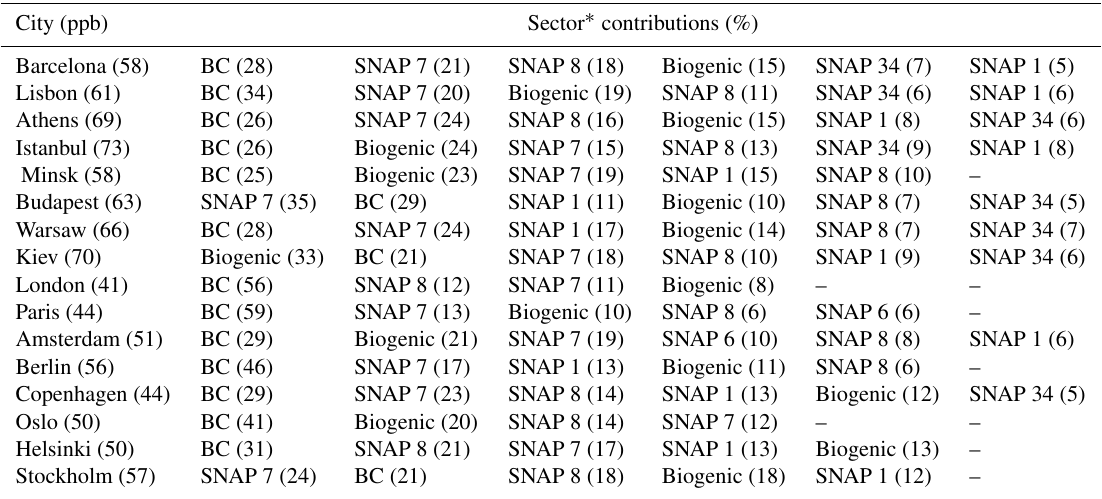
Table 6. Sectors contributing 5% or more to summertime H1MDA8 ozone concentrations. Sector contributions in percentages are shown in parentheses.